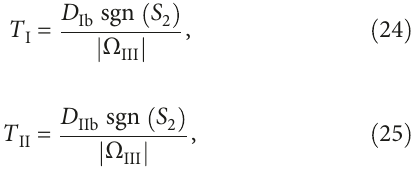
and ω in Step B in the case of J I II